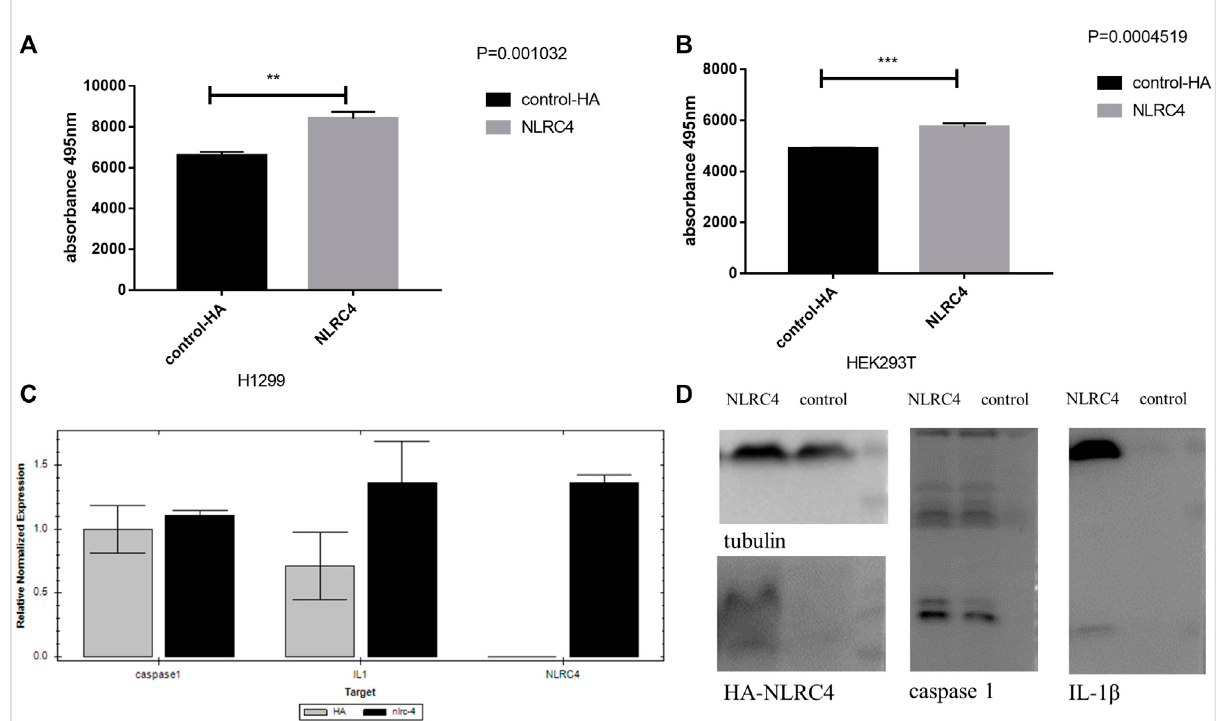
FIGURE 13 Experimental validation of NLRC4 in pyroptosis and lung adenocarcinoma. (A,B) LDH assay. NLRC4 was overexpressed in H1299 and HEK293T cells. We collected the supernatant in each group to test the level of LDH at theabsorbance of 495 nm. (C) Comparison of mRNA levels of downstream related genes when NLRC4 was overexpressed, the difference of caspase 1 was not very obvious, but a higher level of IL-1 β in NLRC4 overexpression group. (D) Activation of in fl ammasome in HEK293T cells by overexpressing NLRC4, pro-caspase 1, ASC and pro-IL-1 β